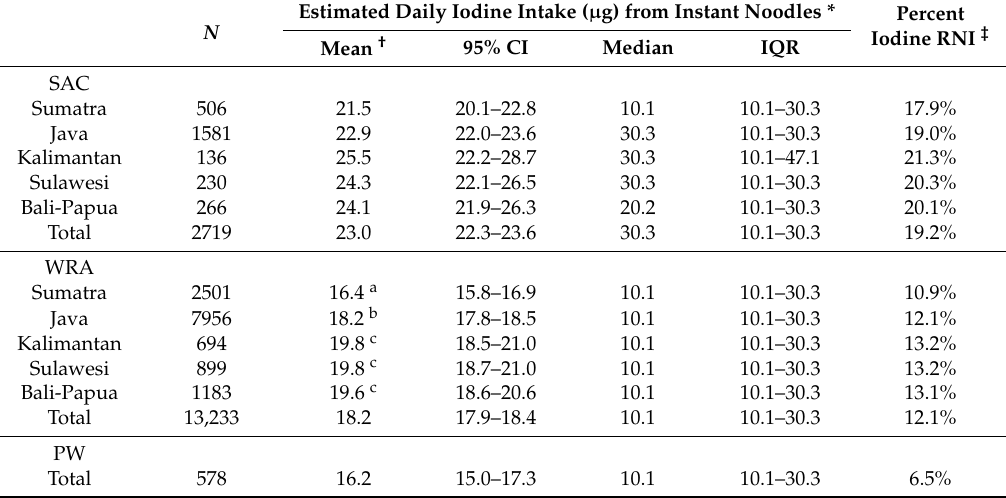
Table 3. Mean and median estimated intakes of iodine ( µ g/day) from the consumption of instant noodles for each respondent group by geographic region.